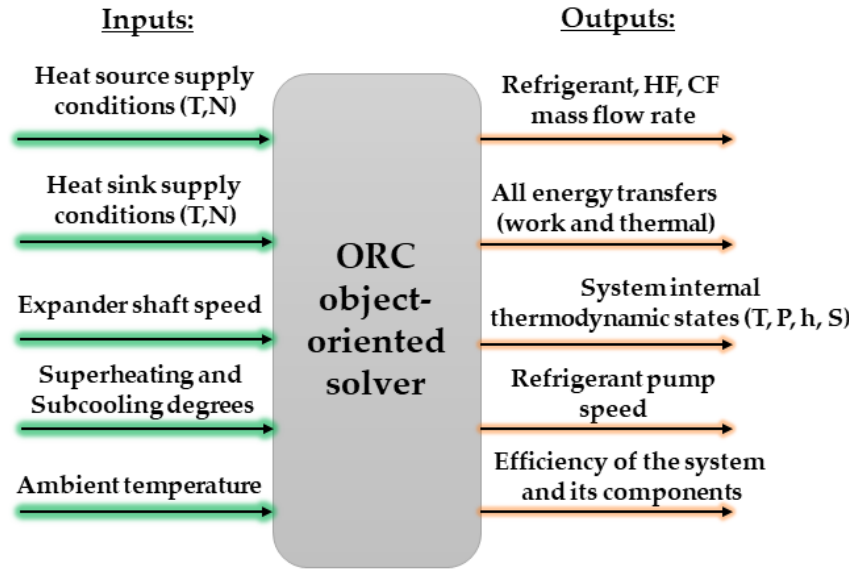
Figure 22. Inputs and outputs of the ORC object-oriented model.